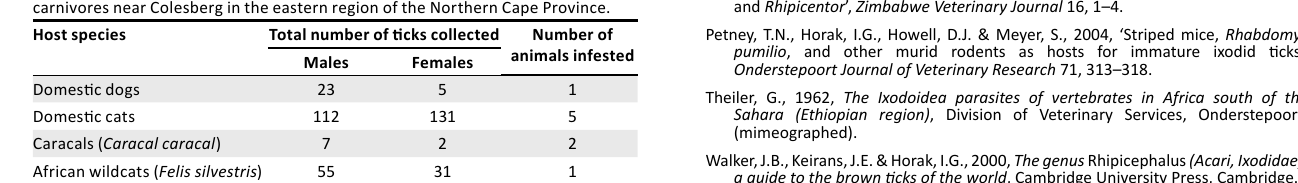
TABLE 3: Species and number of ticks collected from 12 Southern African hedge- hogs in the eastern region of the Northern Cape Province. Tick species Total number of ticks collected Number of Amblyomma marmoreum